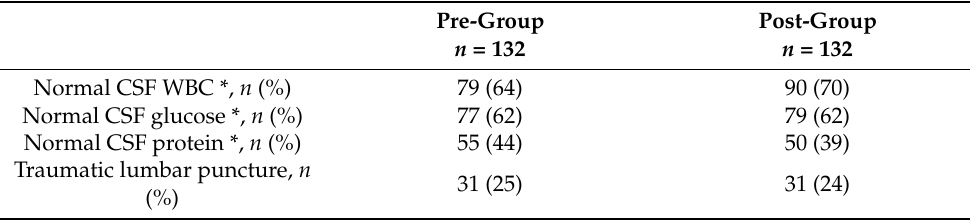
Pre-Group n = 132